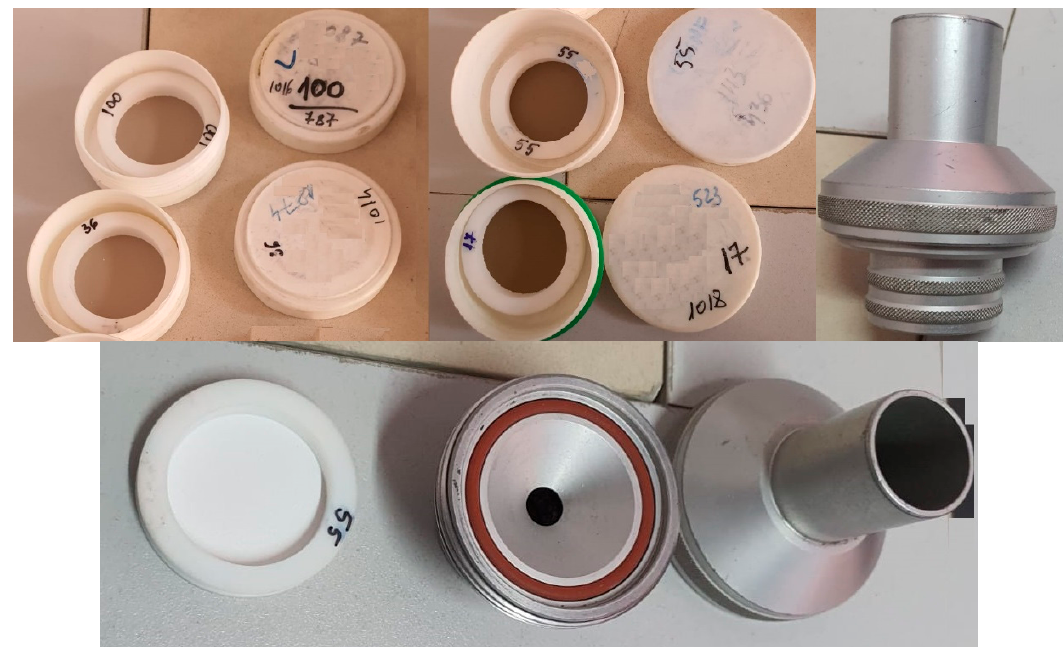
Figure 5. Filters after PM 10 measurements. Table 2. The measured data for PM10 were transformed for standard temperature and atmospheric pressure (0 ◦ C and